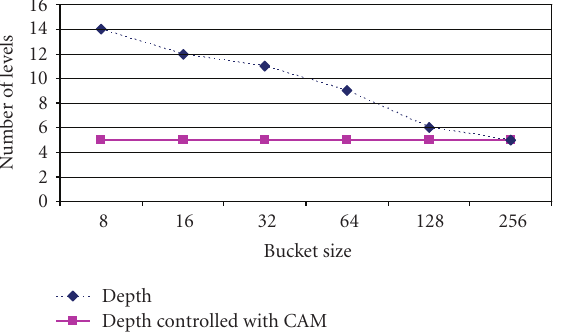
Figure 7: Restricting maximum depth of the tree (number of levels) to 5 using CAM.